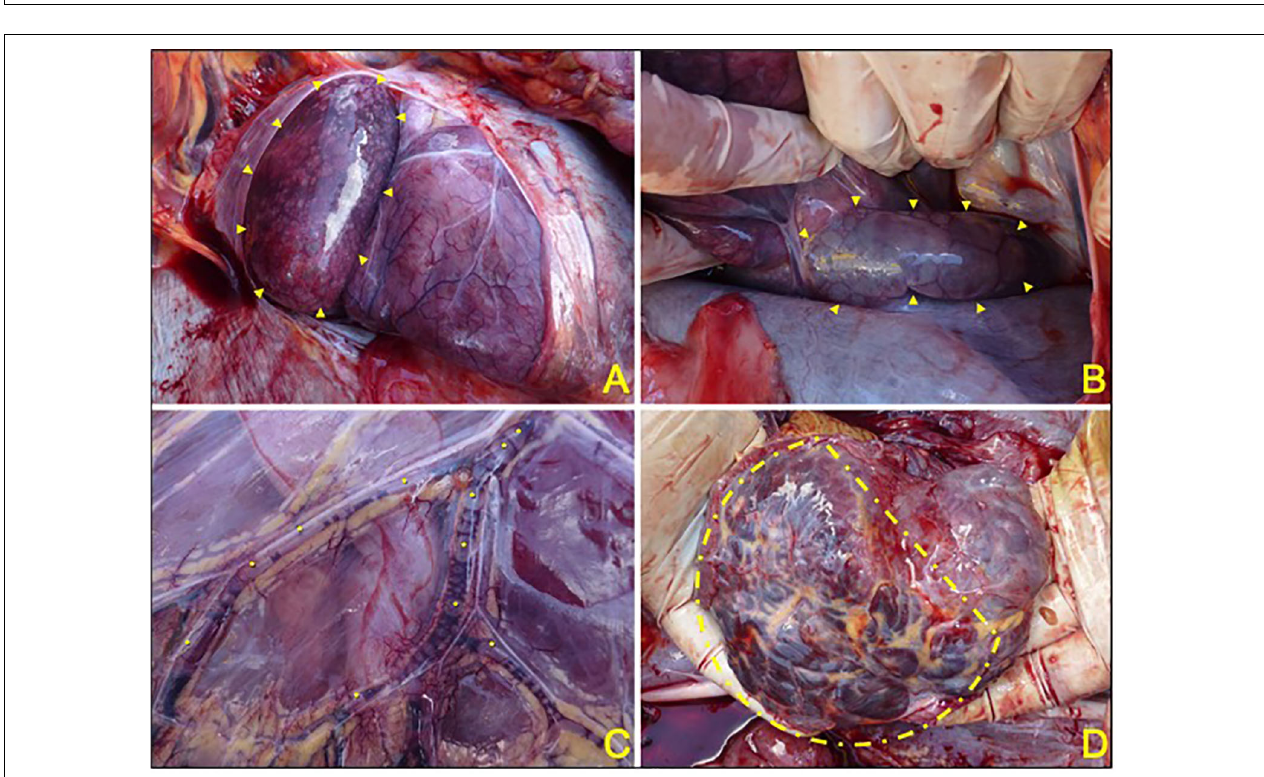
FIGURE 2 | Sequence of ultrasound images of the renal area of the olive ridley turtle, within 30–40 min intervals. A clear increase in the presence of gas in vessels and renal parenchyma is observed. (A) Mild gas embolism. Initial ultrasound after approximately 20 min of being surfaced. (B) Moderate gas embolism: The amount and distribution of gas increase in blood vessels and renal parenchyma. (C) Severe gas embolism. Massive amount of gas preventing ultrasound penetration and tissue visualization.